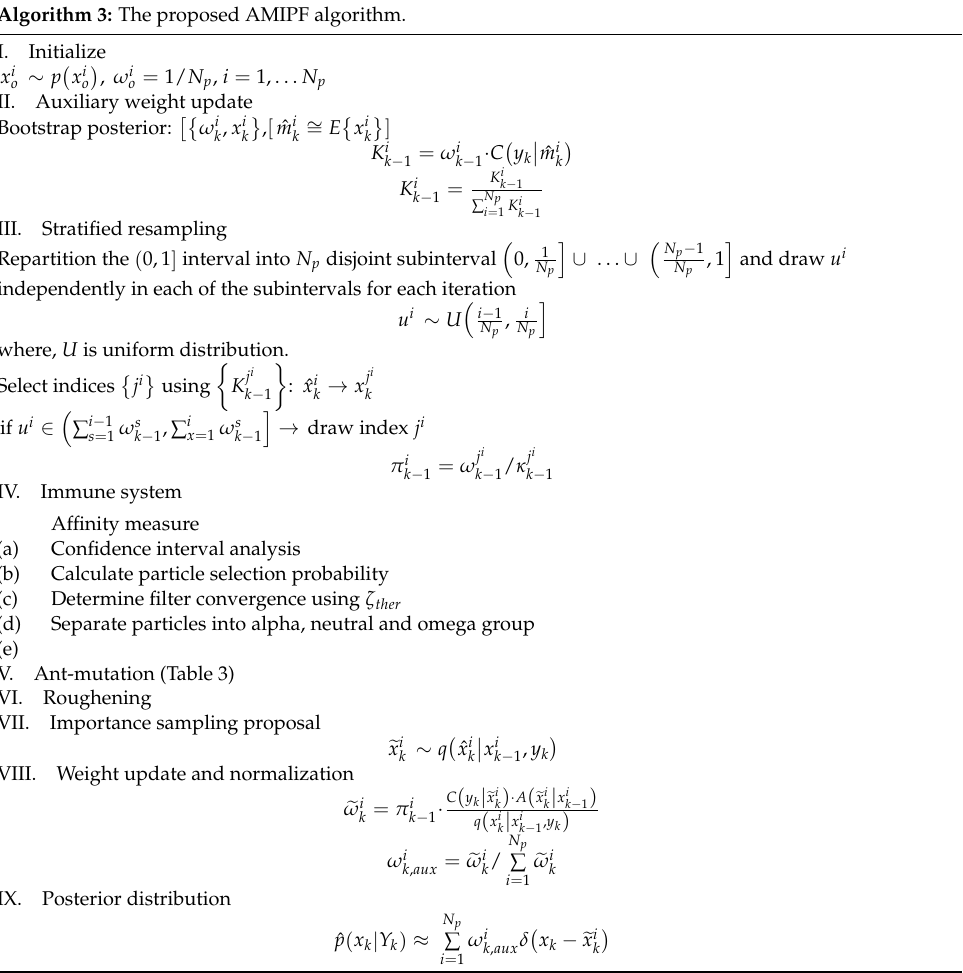
Algorithm 3: The proposed AMIPF